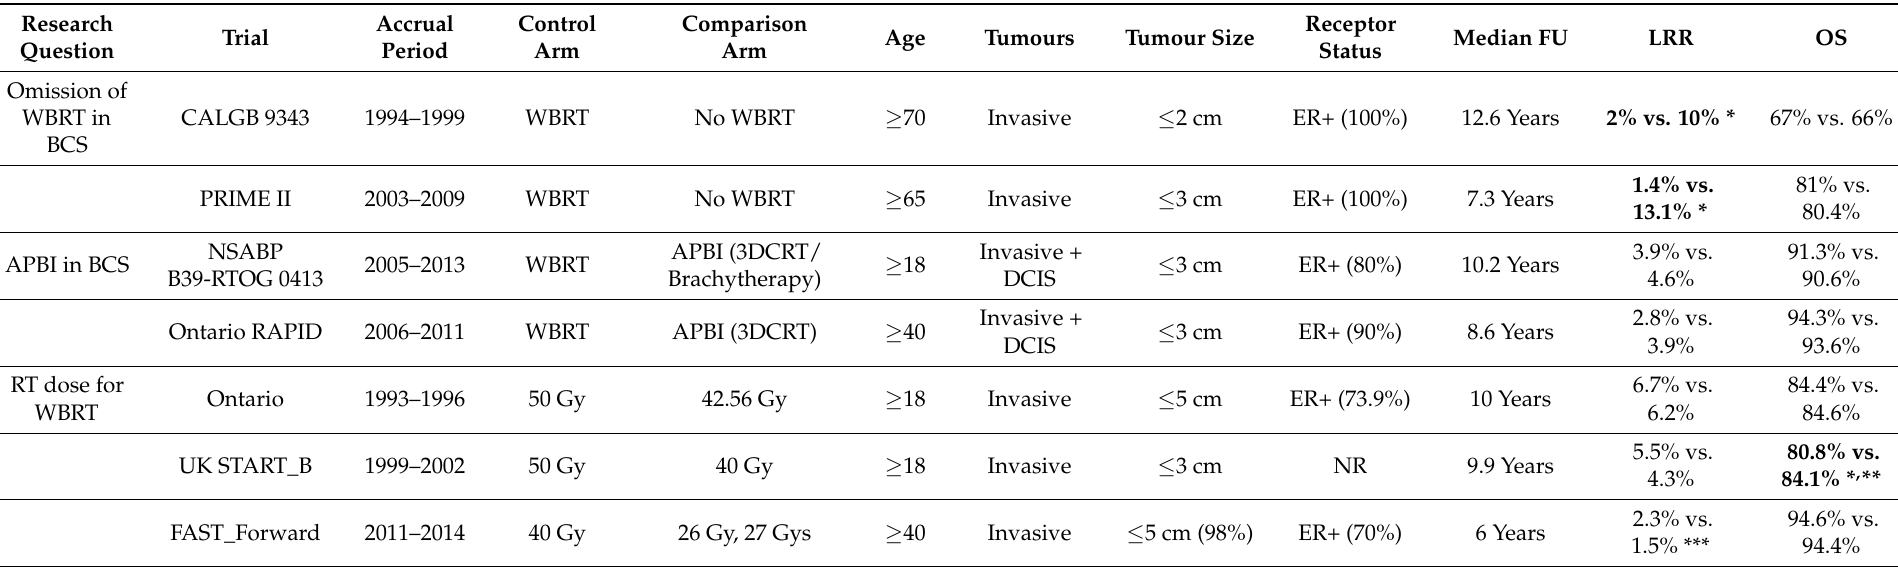
Table 1. Trials for low-risk breast